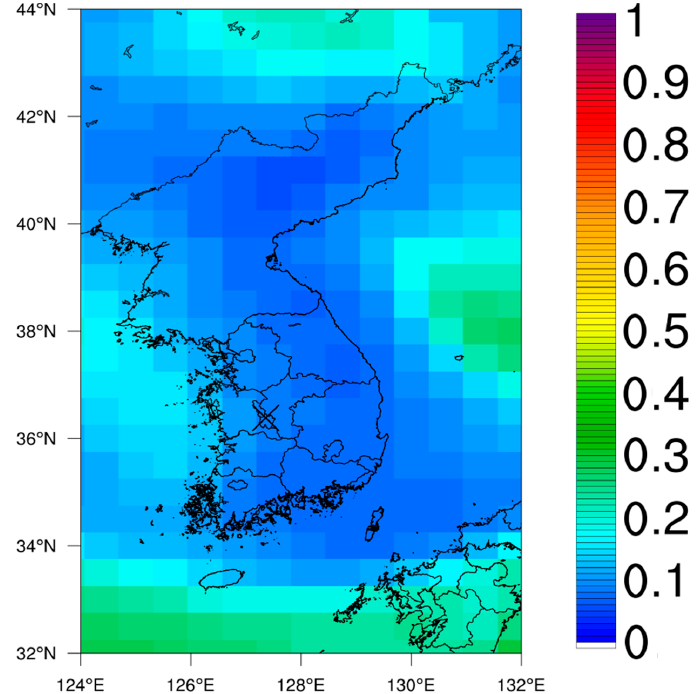
Figure 12. Horizontal distribution of daily mean aerosol optical depth on Julian day 33 (2 February 2021) at 550 nm from Modern-Era Retrospective Analysis for Research and Applications Version 2 (MERRA-2) reanalysis data.